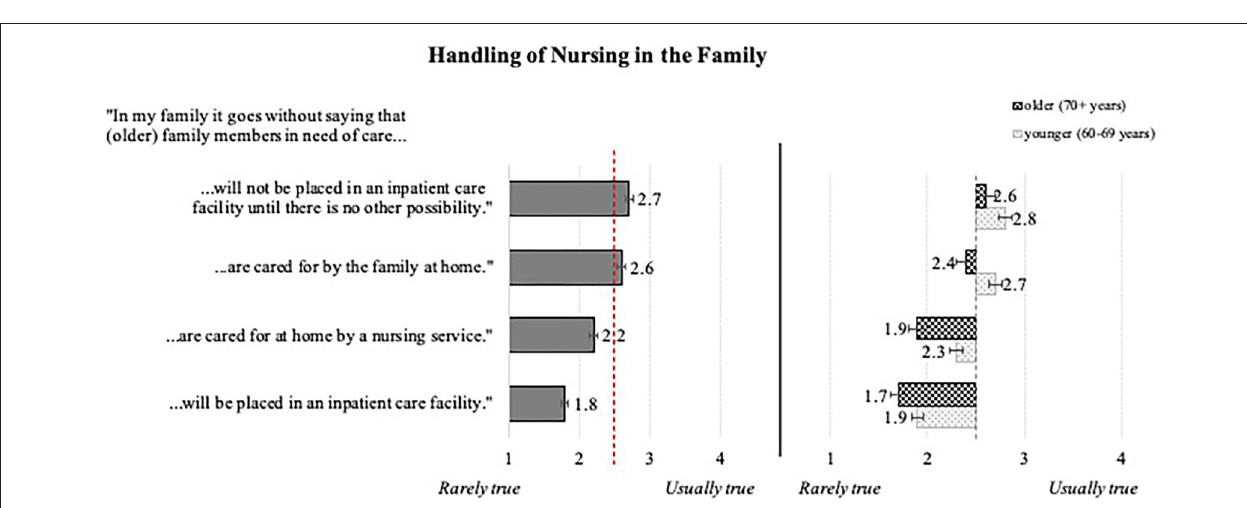
FIGURE 4 | Evaluations of the handling of nursing in the family: overall means (Left) and effect of age ( Right ; N =